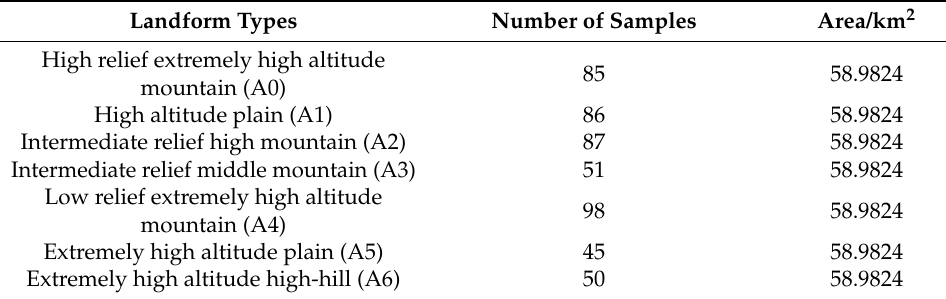
Table 2. Number of different landform